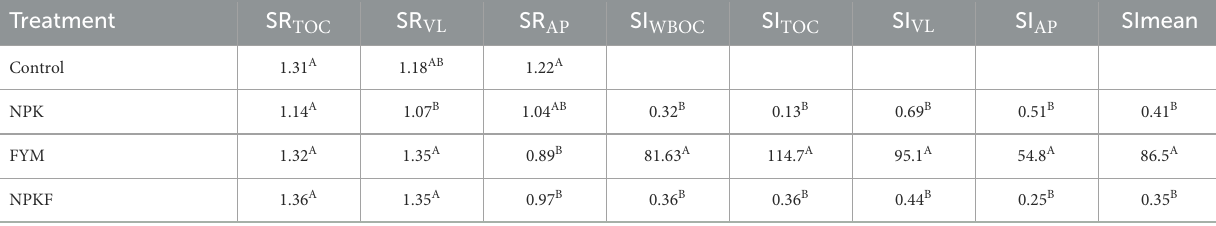
TABLE 5 Effect of nutrient management practices on SOC stratification ratio (SR) and sensitivity indices (SI, %).